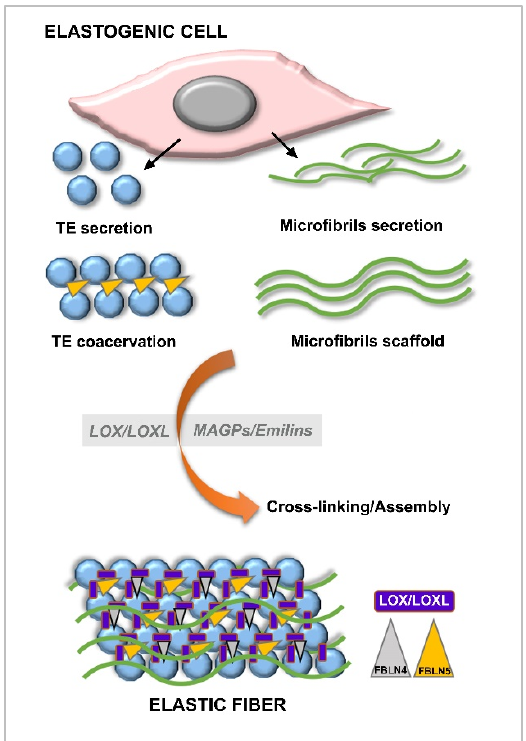
Figure 5. Process of elastogenesis and the molecular interactions among the different components of the elastic fiber. Functions of LOX/LOXL, fibulin-4 (FBLN4), and fibulin-5 (FBLN5) during coacervation, crosslinking, and assembly have been